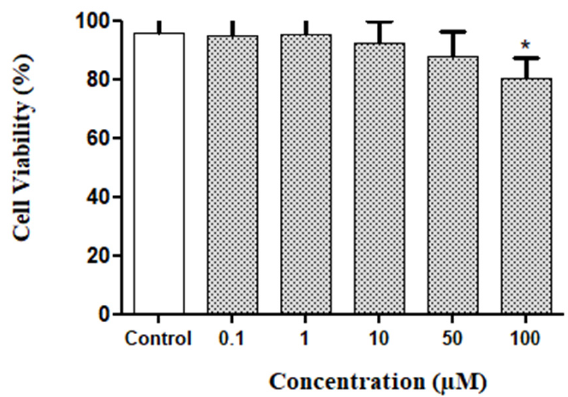
Figure 4. Percentage of cell viability in glial cell cultures of rats after 24 h of exposure to the Z90718 molecule (MTT assay). (*) Significant differences from negative control ( p < 0.05).